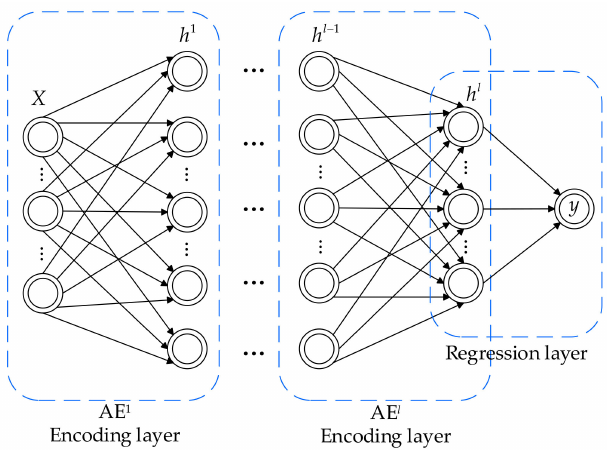
Figure 3. The architecture of the SAE.